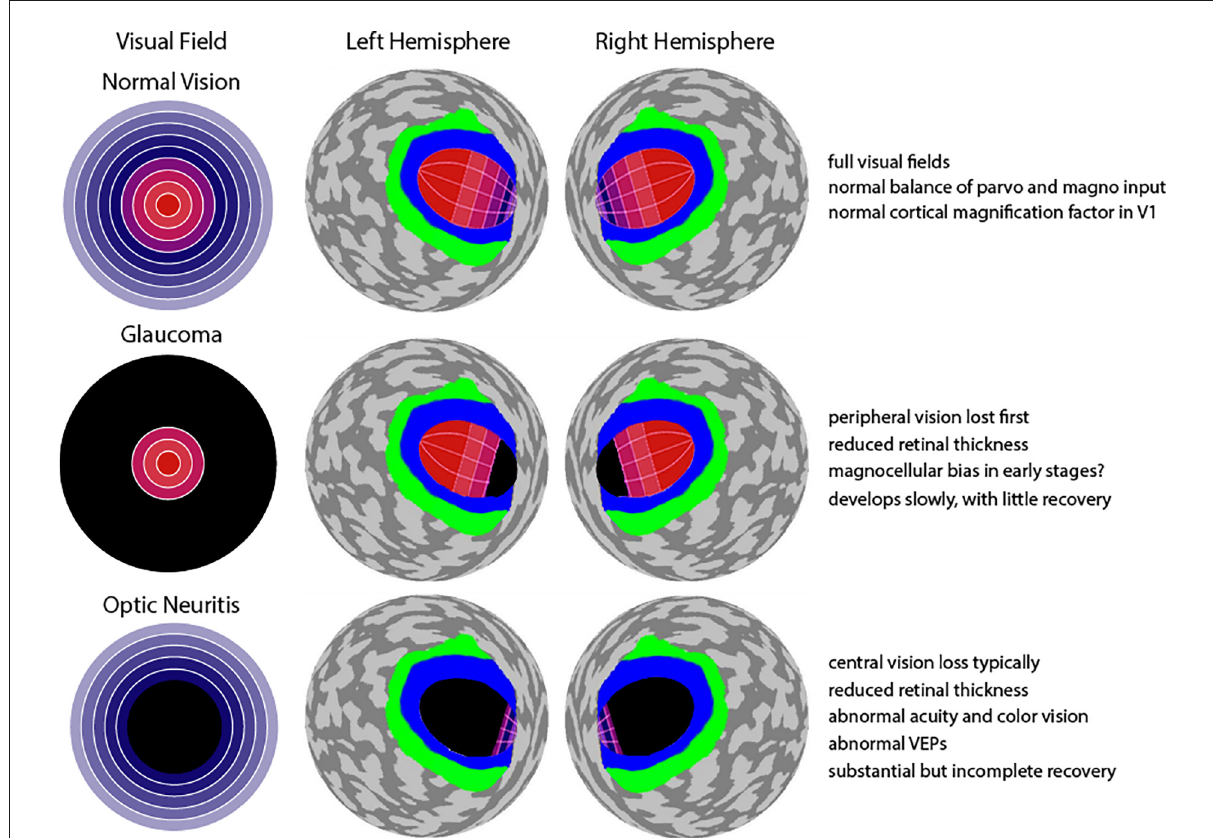
FIGURE2 Effect of glaucoma and optic neuritis on visual field and visual cortex. Top row : A normal visual field diagram with orange and purple signifying central and peripheral vision, similar to Figure 1 is shown. To the right is an abstracted (spherical) representation of both the left and right hemispheres of cerebral cortex, posterior view (Benson and Winawer, 2018). Area V1 is labeled with the same orange-to-purple color gradient used for the visual field. It can be seen that the central vision occupies a disproportionally large region of V1, with very little territory devoted to the periphery. A similar representation also exists in areas V2 and V3, but this is not shown. Instead, area V2 is simply shown in blue, and area V3 in green. Middle row : Loss of peripheral vison in glaucoma leads to deafferentation of a relatively small portion of anterior V1 (shown with black) due to the cortical magnification factor. Bottom row : Loss of central vison in optic neuritis leads to deafferentation of a quite large proportion of V1 (shown with black) due to the exponential expansion of central field input. Text in far right summarizes features for normal vision, glaucoma, and optic neuritis. Note: depiction of cortical magnification factor in V1 remade from a source at https://mosaicofminds.medium.com/maps-in-